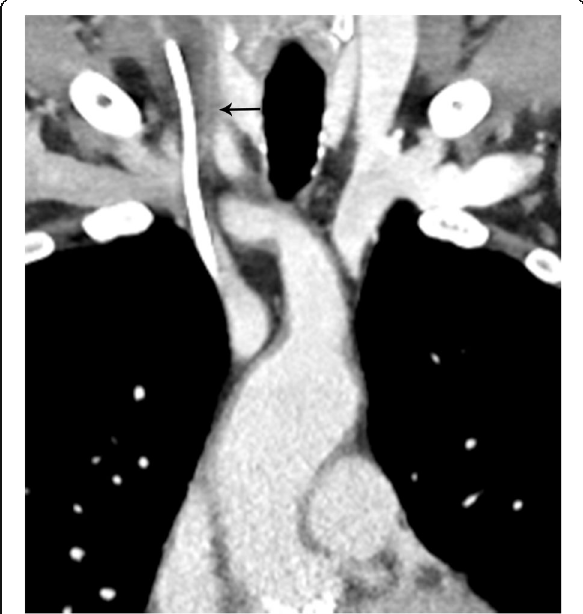
Fig. 7 Internal jugular vein thrombus. Coronal contrast CT image demonstrating a catheter within the right internal jugular vein and nonopacification of the vessel, findings consistent with right internal jugular vein catheter-associated